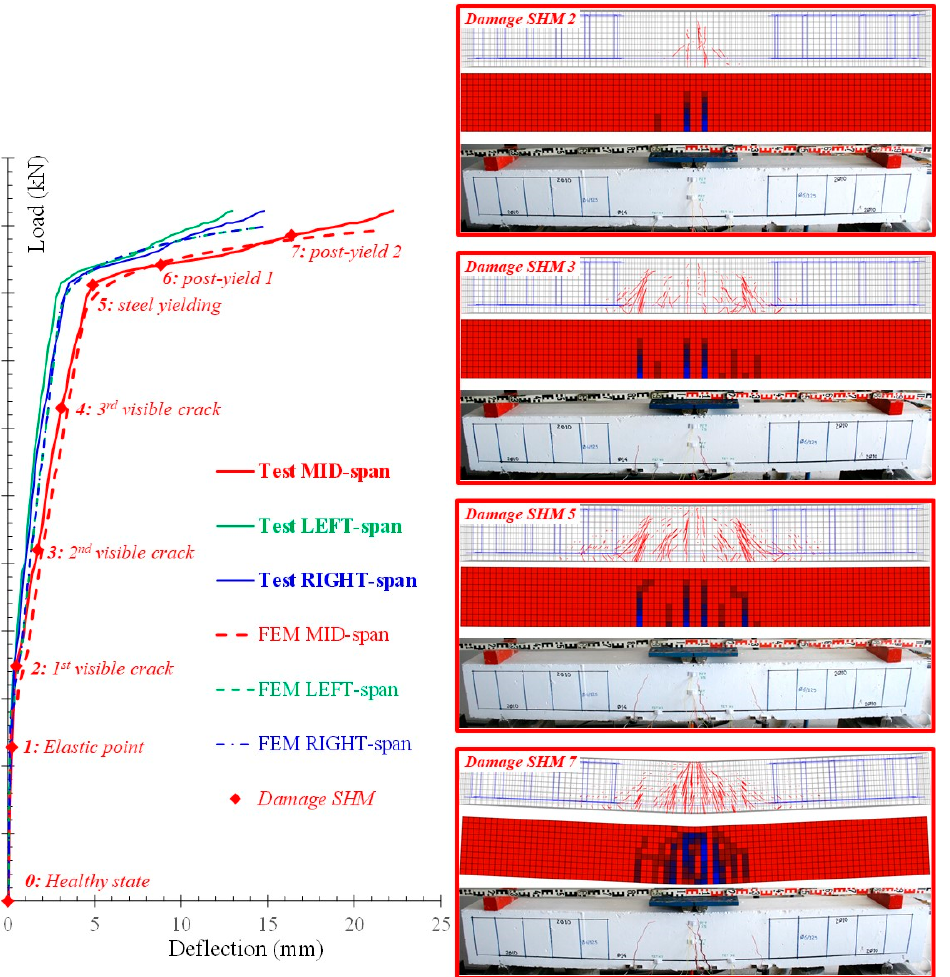
Figure 12. Comparisons between test and simulation results of the FLM beam under monotonic loading in load versus deflection curves and cracking patterns per various loading/damage levels.